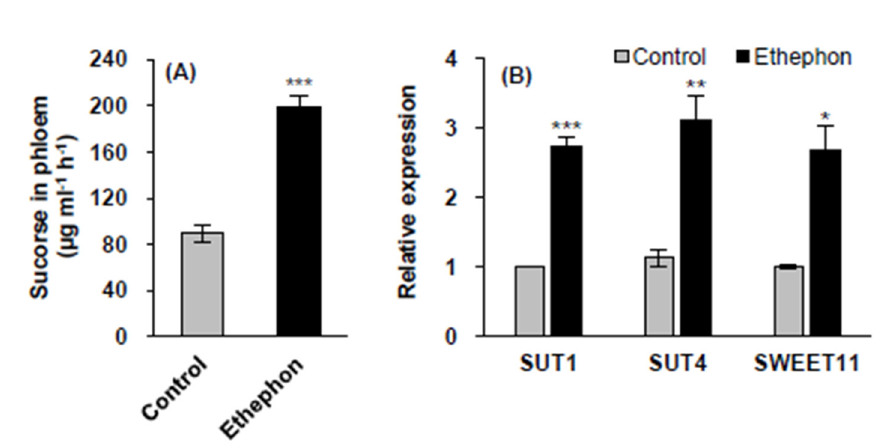
Figure 4. Sucrose content in phloem ( A ) and expression of sucrose transport-related genes SUT1 , SUT4. and SWEET11 ( B ) in mature leaves in control or ethephon-treated plants for 10 days. Data are presented as mean ± SE ( n = 3). The qRT-PCR was performed in duplicate for each of the three independent biological samples. Significant differences between treatments are represented by * P < 0.05, ** P < 0.01, *** P < 0.001.